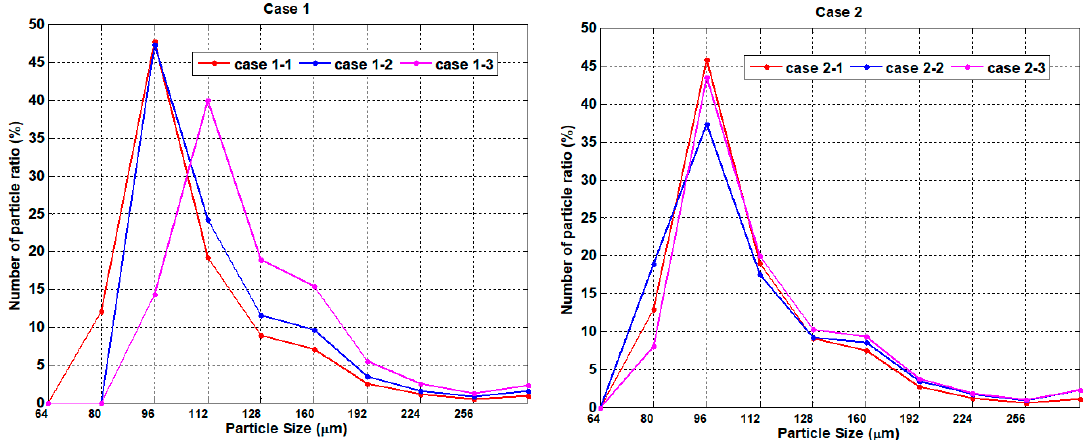
Figure 6. Ratio of number of particles according to particle size and concentration.